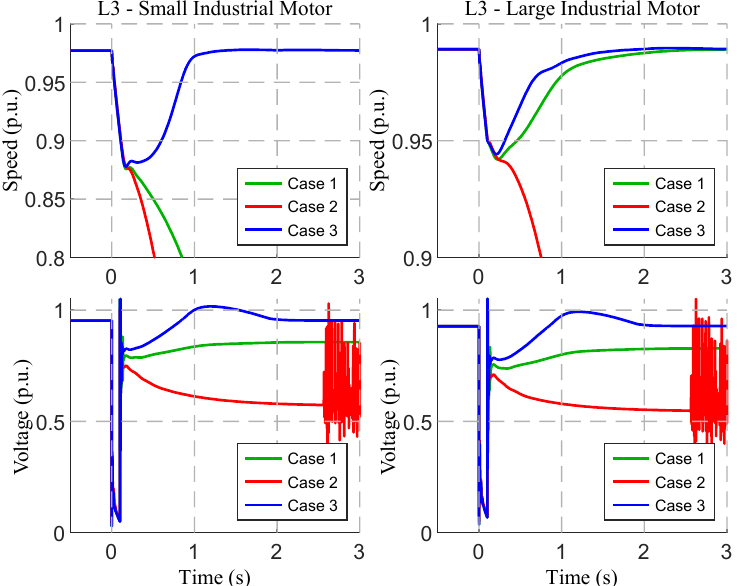
Figure 36. L3 large industrial motor ( left ) and refrigerator type IM loads speeds and terminal volt- ages.